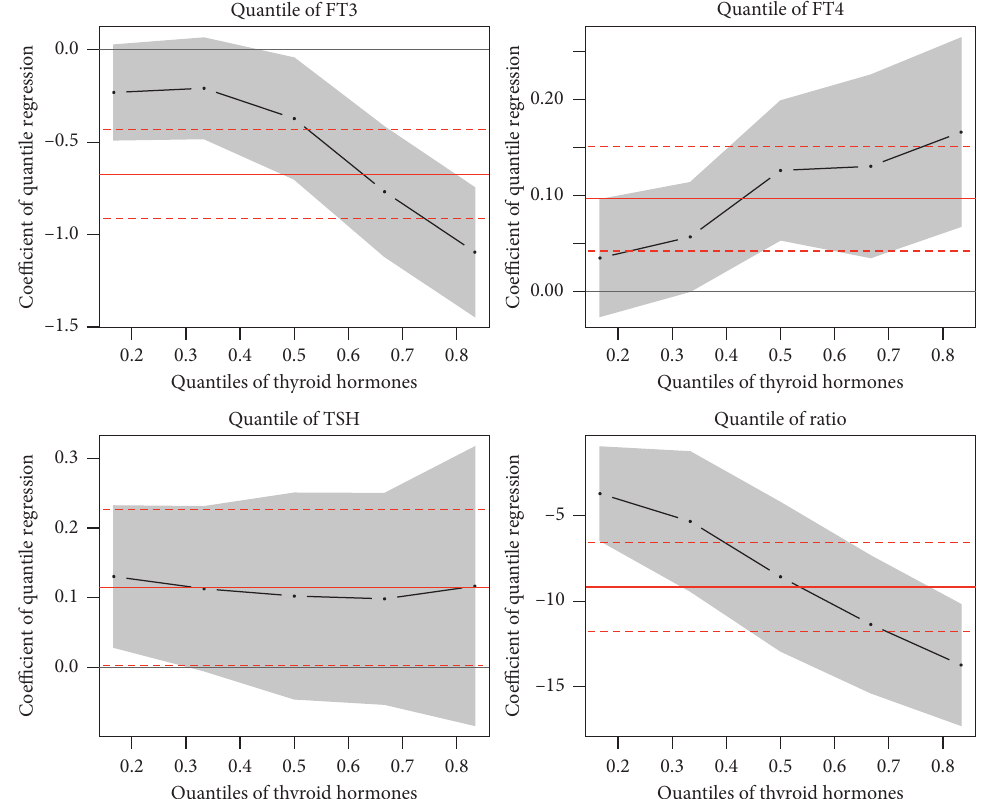
Figure 2: Coefficients of quantile regression between HbA1c levels and thyroid hormones after adjusting for BMI, duration of T2D, smoking status, TG, and history of hyperlipidemia.